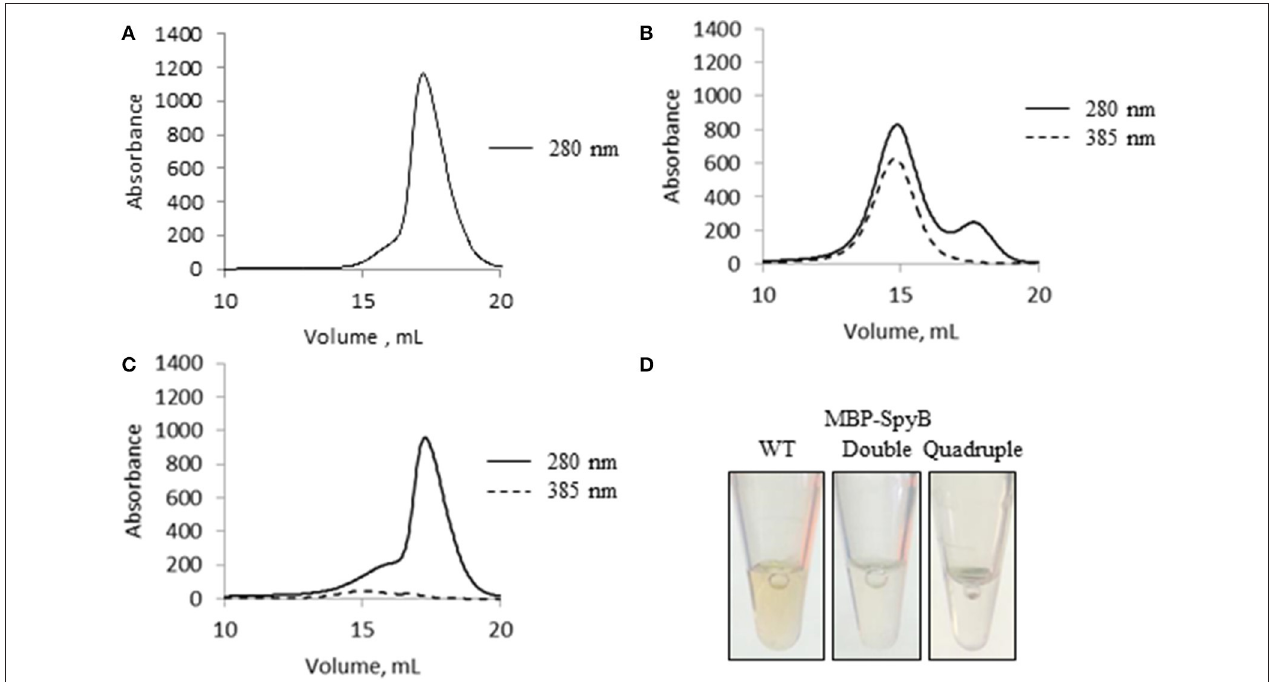
FIGURE 6 | Hemin binding induces SpyB oligomerization. (A) The size-exclusion chromatogram of MBP-SpyB monomer. (B) The size-exclusion chromatogram of MBP-SpyB monomer reconstituted with hemin in 1:4 ratio. (C) The size-exclusion chromatogram of MBP-SpyB monomer reconstituted with protoporphyrin IX in 1:4 ratio. The absorbance was monitored at 280 and 385 nm (hemin and protoporphyrin IX detection). (D) The appearance of WT MBP-SpyB, and double (C7A/C13A) and quadruple (C7A/C13A/C30A/C35A) MBP-SpyB mutants, following expression in E. coli Rosetta DE3 cells and purification by Ni-NTA affinity chromatography and size-exclusion chromatography. Data are representative of biological triplicates.